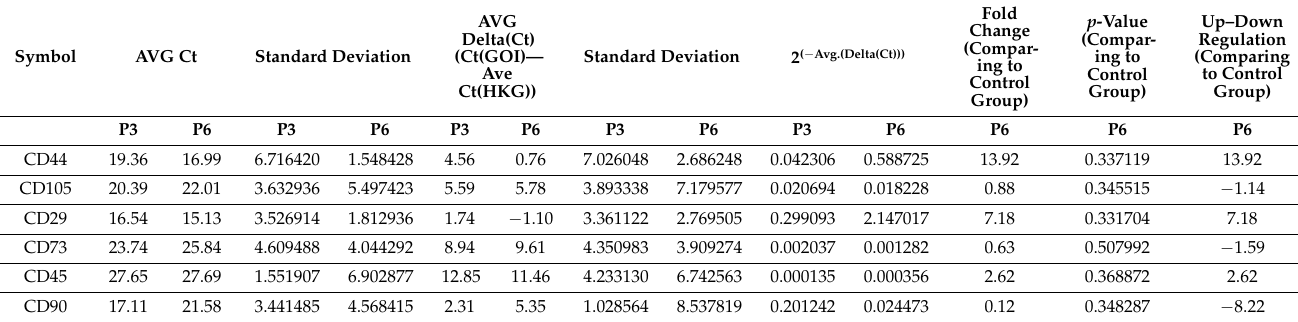
Table 1. Changes in gene expression between passage 3 and passage